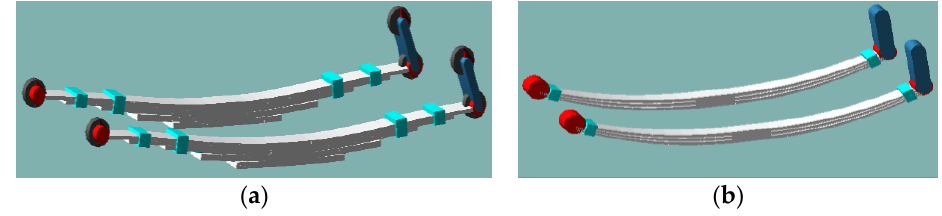
Figure 5. The simulation models: ( a ) The multi-leaf spring; ( b ) the taper-leaf spring.